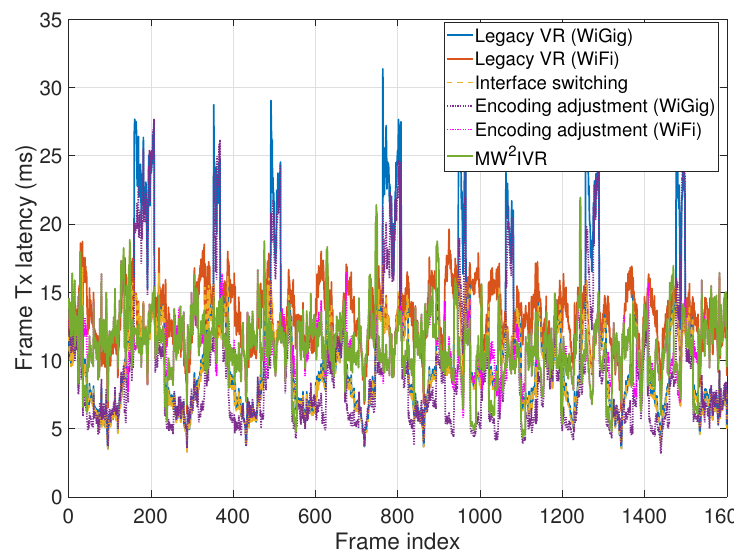
Figure 10. Frame transmission latency over time.